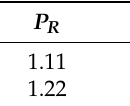
Table 1. Operating